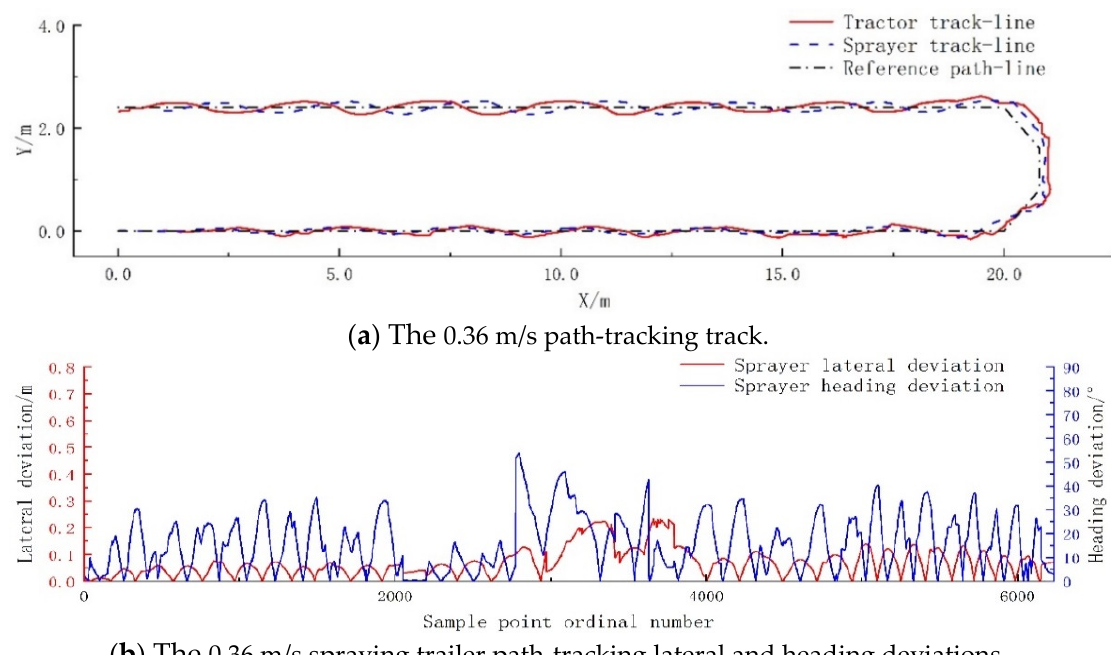
( b ) The 0.36 m/s spraying trailer path-tracking lateral and heading deviations. Figure 18. Cont